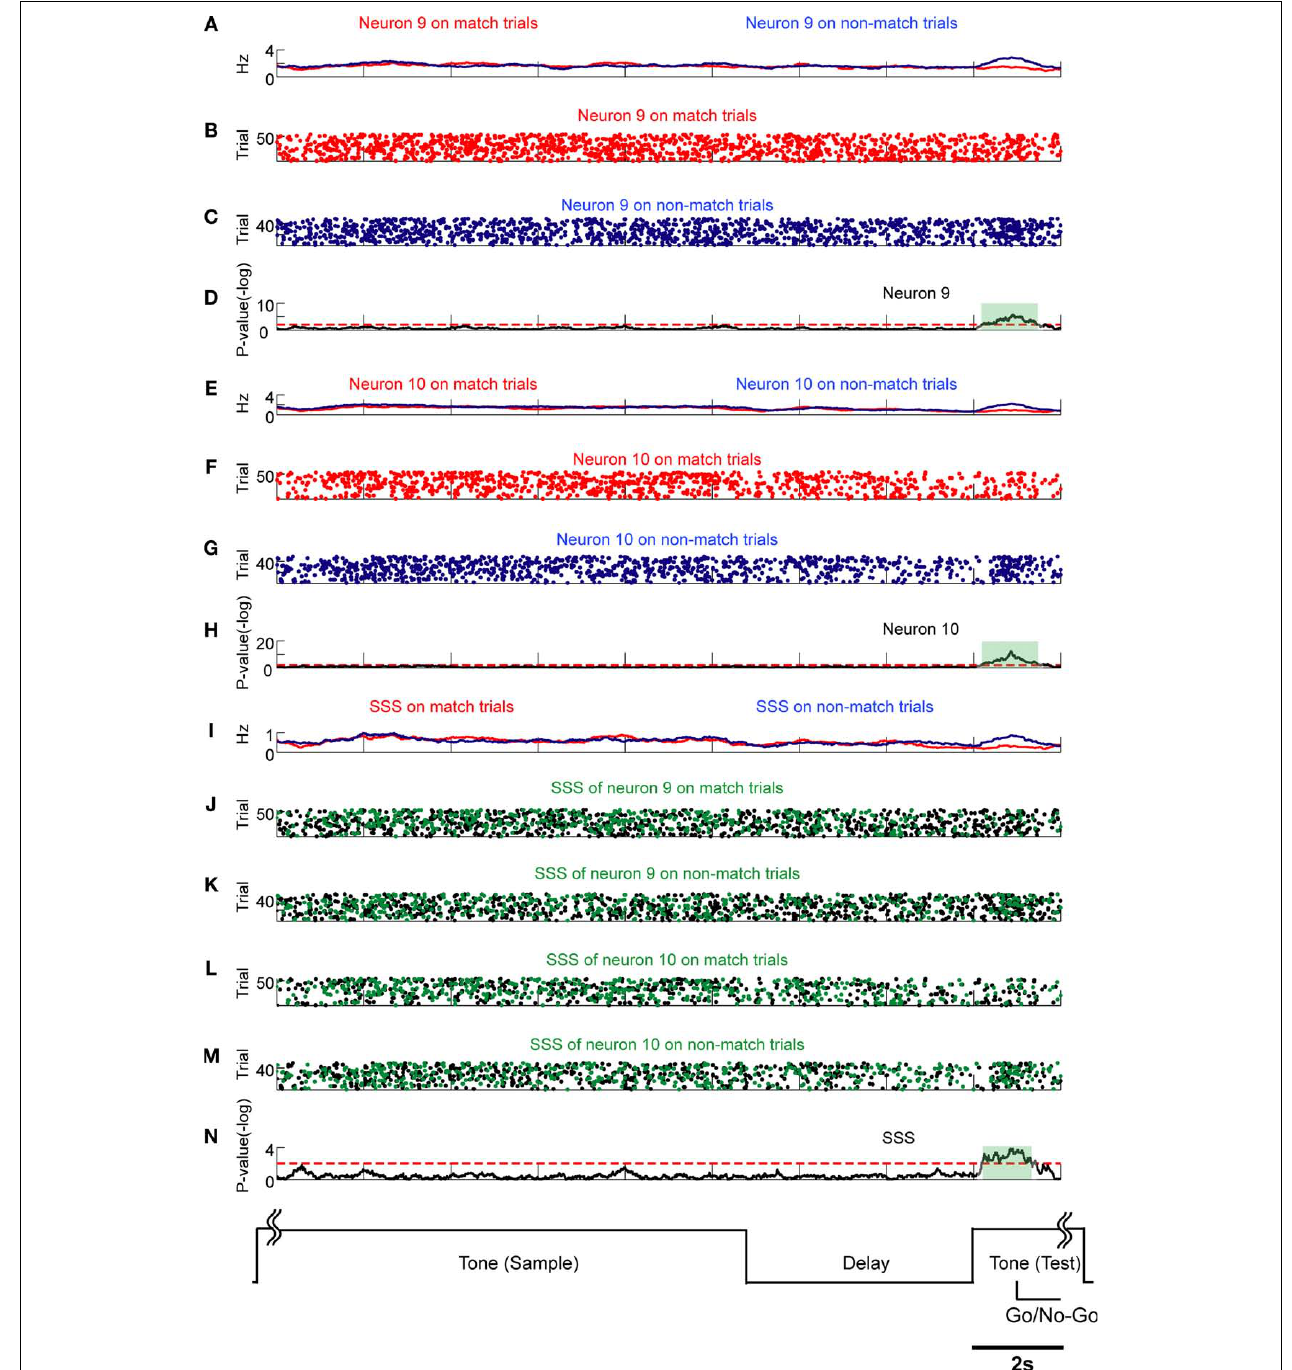
FIGURE 7 | SSSs related to motor outputs are associated with fi ring rate modulations. Comparison of SSSs and rate modulations between non-match/ match (go/no-go) trials was selected in this example. Each subfi gure averages all correct trials of a session. Results of U -tests of 11 s of tone presentation in the preceding trial, 5 s of delay, and 2 s of tone presentation in the next trial are shown. (A) Firing rates of neuron 9 in match (red) and non-match (blue) trials. (B,C) Raster plots of spikes of neuron 9 in match (red) and non-match (blue) trials. (D) P -values of